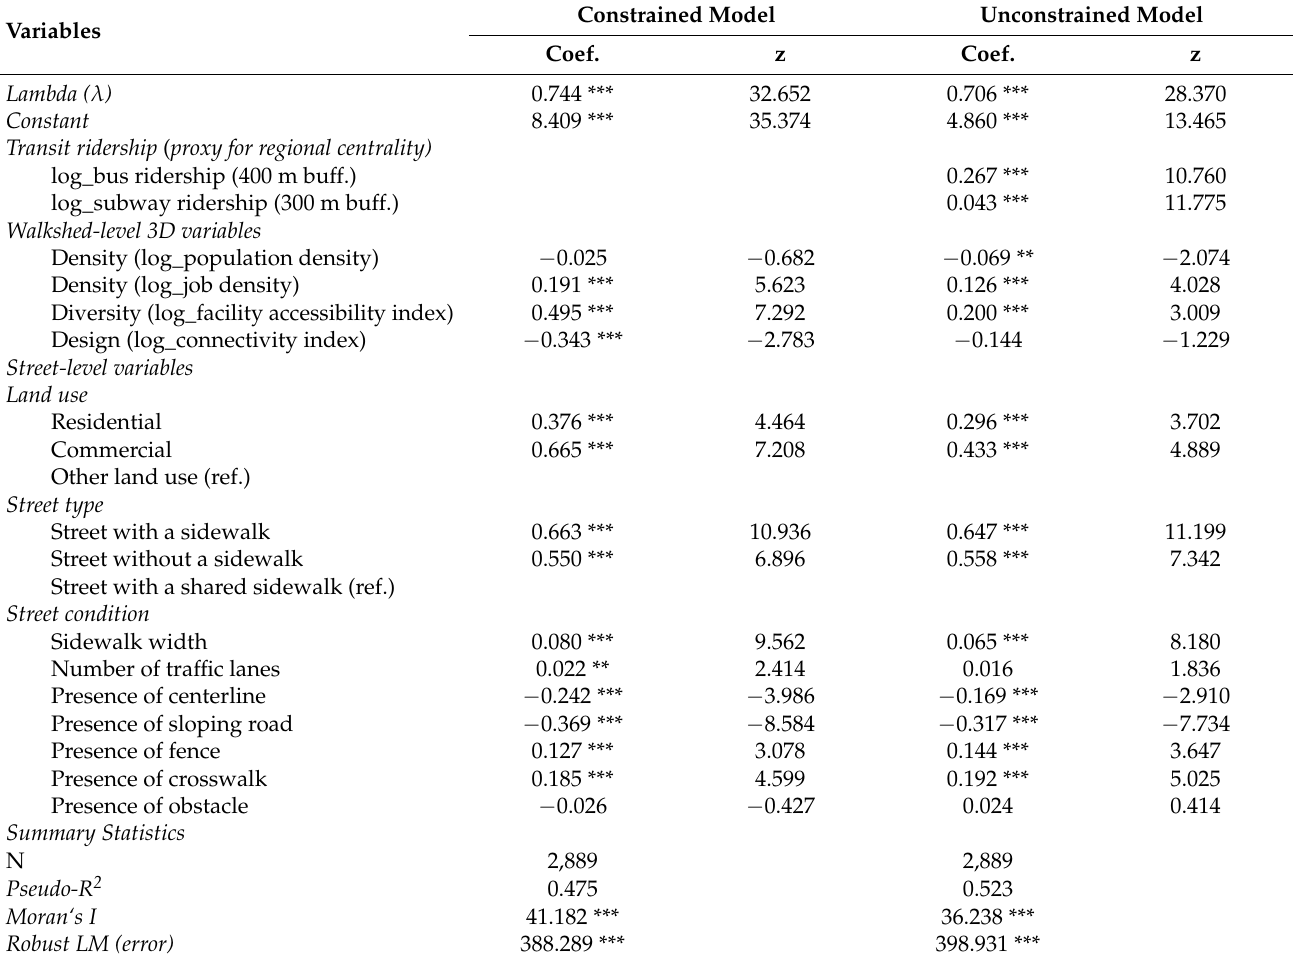
Table 4. Spatial regression (spatial error) models of log-transformed street-level pedestrian